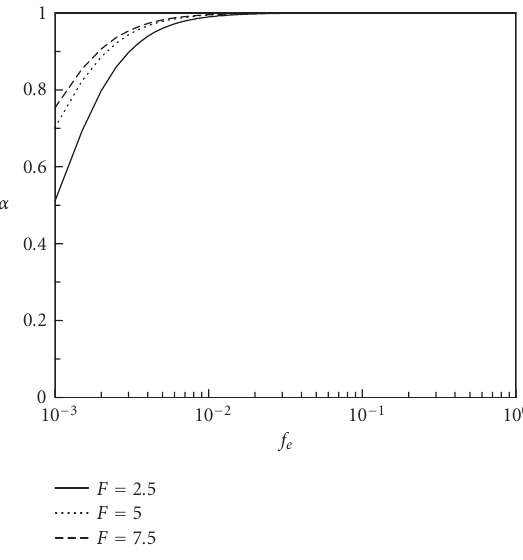
Figure 4.3. Spatial growth rate α = k i /k min